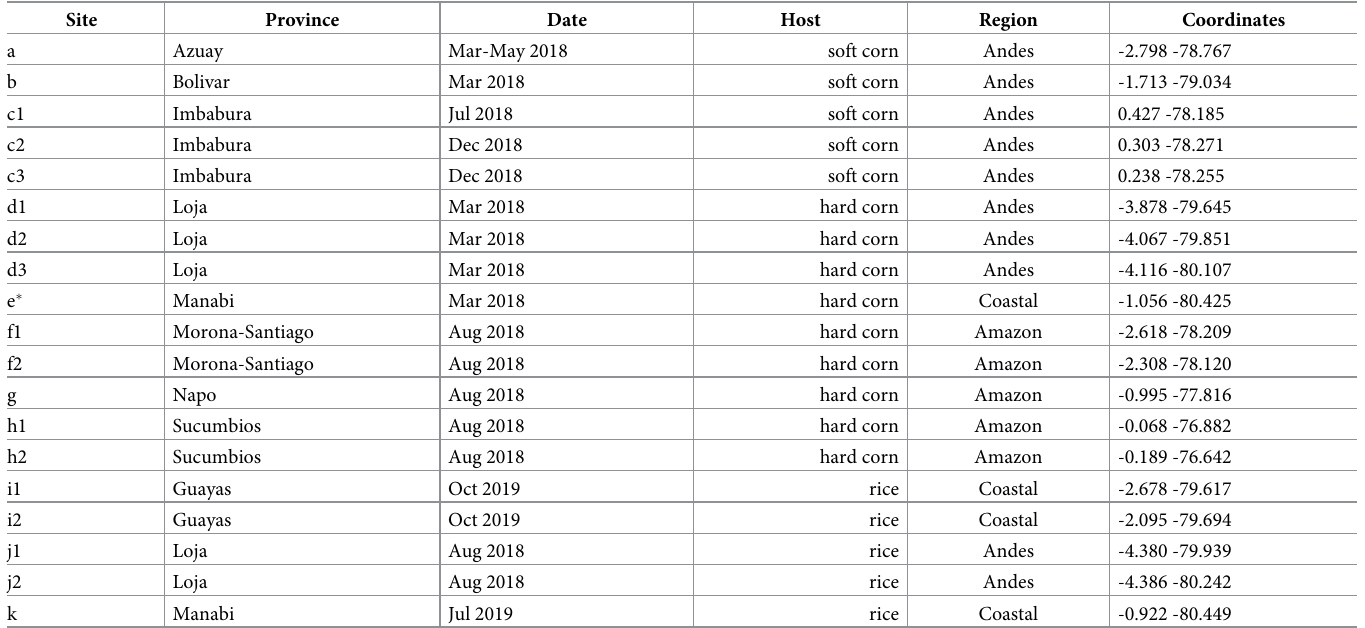
Table 1. Source information for fall armyworm collections. Number refers to map locations in Fig 1. Asterisk indicates collection from